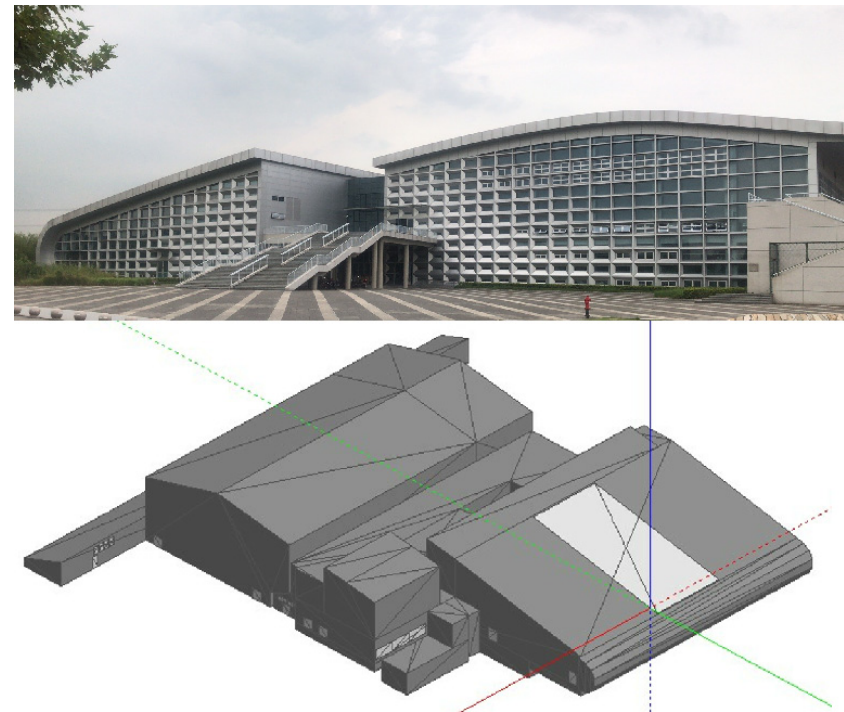
Figure 8. A sports center and its BPS model in a case study. Table 9. Model parameters of the building case study.